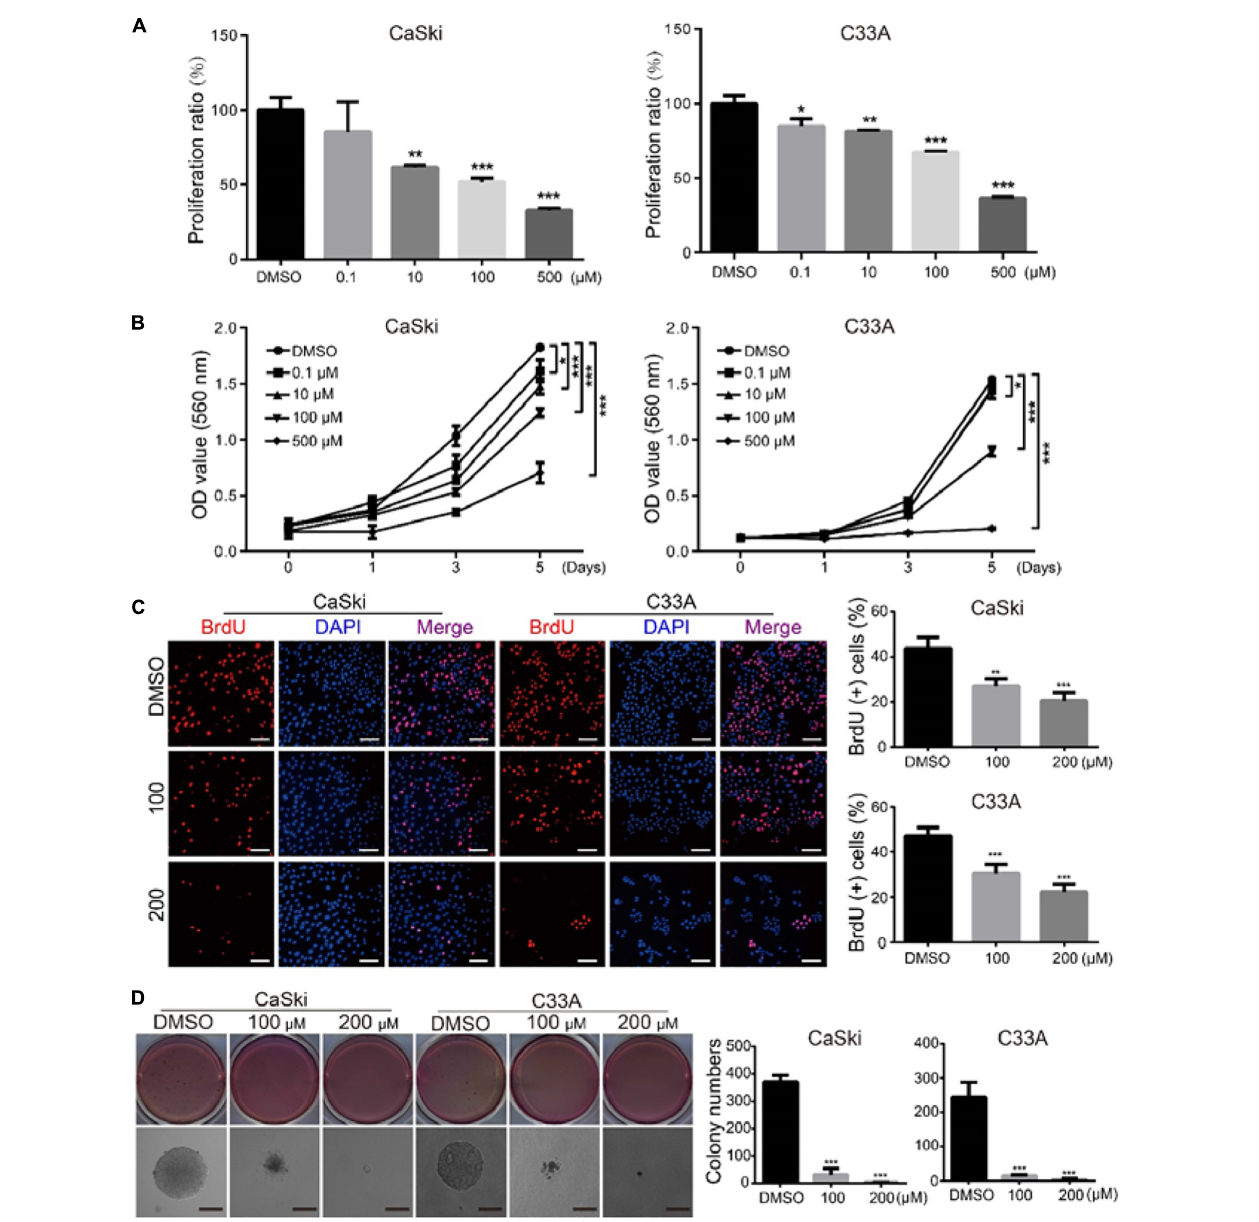
FIGURE 1 | Polydatin inhibits cervical cancer cell growth and proliferation. (A) CaSki and C33A cervical cancer cells after treating with dimethyl sulfoxide (DMSO) or the indicated concentrations of polydatin for 72 h. The histogram demonstrates the quantification of proliferation ratio. DMSO was used as the control. (B) Cell growth was monitored using MTT assays in cells treated with polydatin at the indicated time and concentrations. (C) Immunofluorescence staining for BrdU was performed. DAPI was used for nuclear staining. Scale bar, 20 µ m. The histogram demonstrates the quantification of the ratio of BrdU-positive cells. (D) The colony formation was examined by soft agar assays (1,000 cells/well) in CaSki and C33A cervical cancer cells after treating with DMSO or polydatin at the indicated concentrations for 14–21 days, Scale bar, 100 µ m. All data were analyzed using two-tailed Student’s tests. Error bars, ∗ P < 0.05, ∗∗ P < 0.01, and ∗∗∗ P <